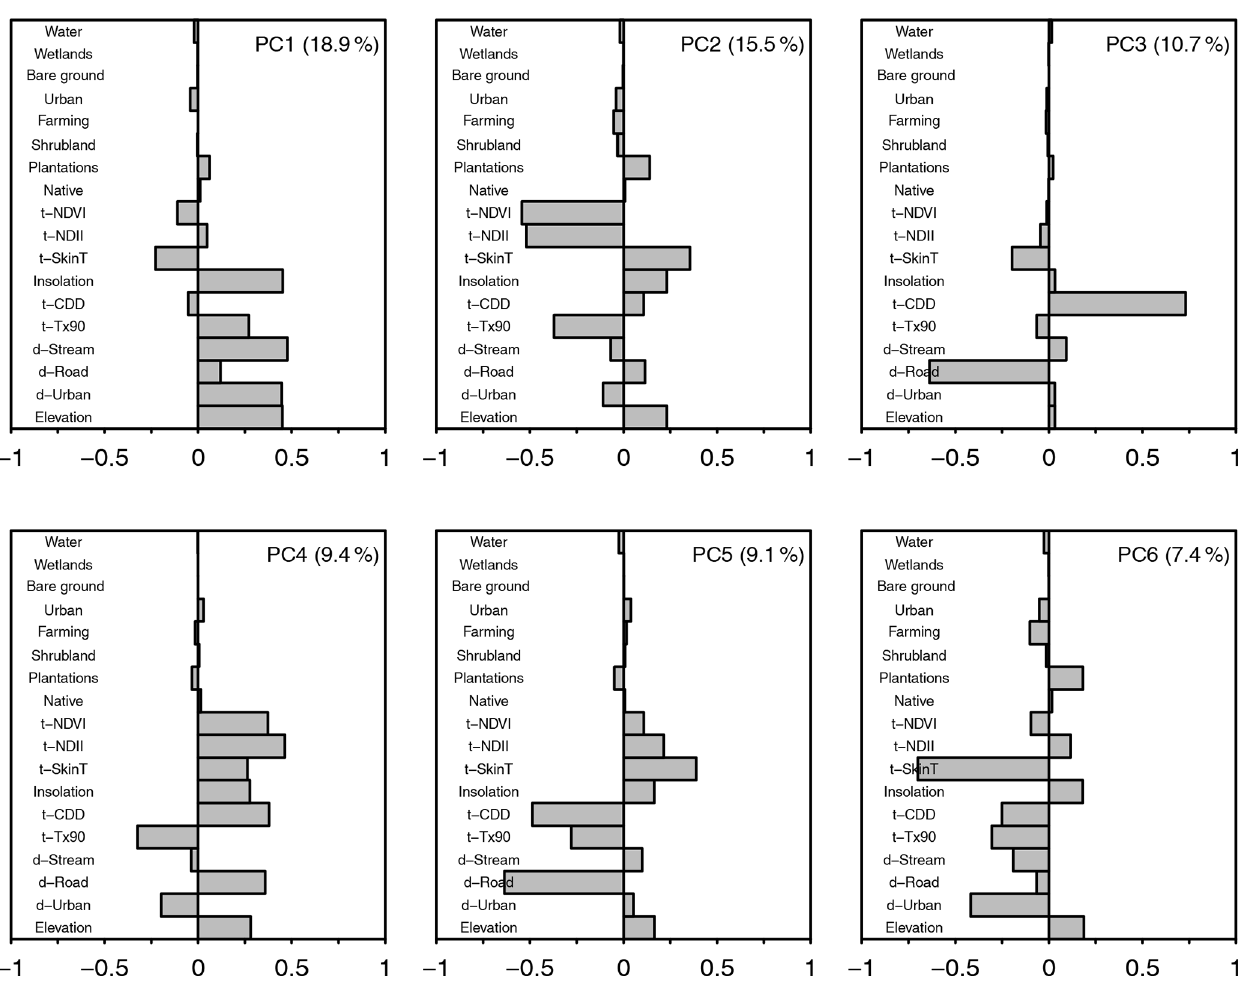
Figure 4. Input to the SOM model presented as percentages of six principal components